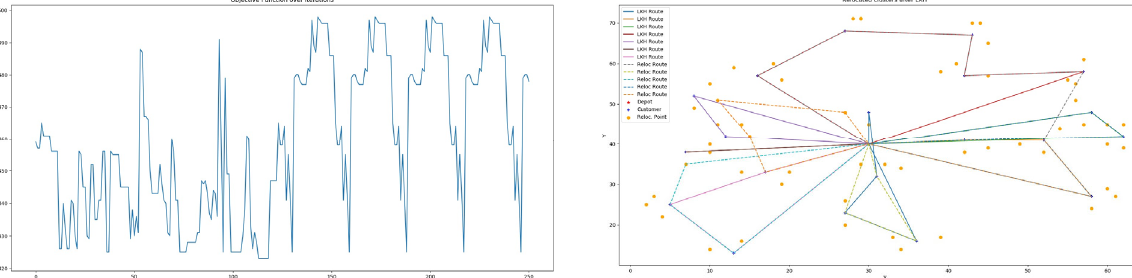
Fig. 9. Behavior of the objective function for the algorithm with packing considerations (Instance 4)